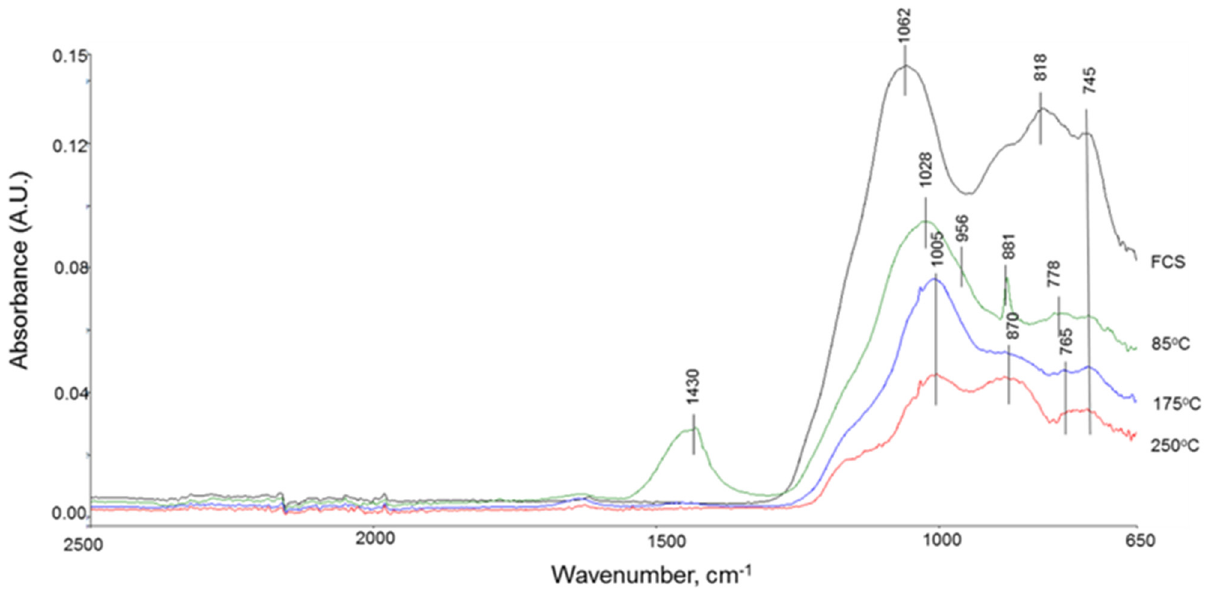
Figure 5. ATR-FTIR spectra of “as-received” FCS and FCS/SMS samples made at hydrothermal temperatures of 85°, 175°, and 250 °C.